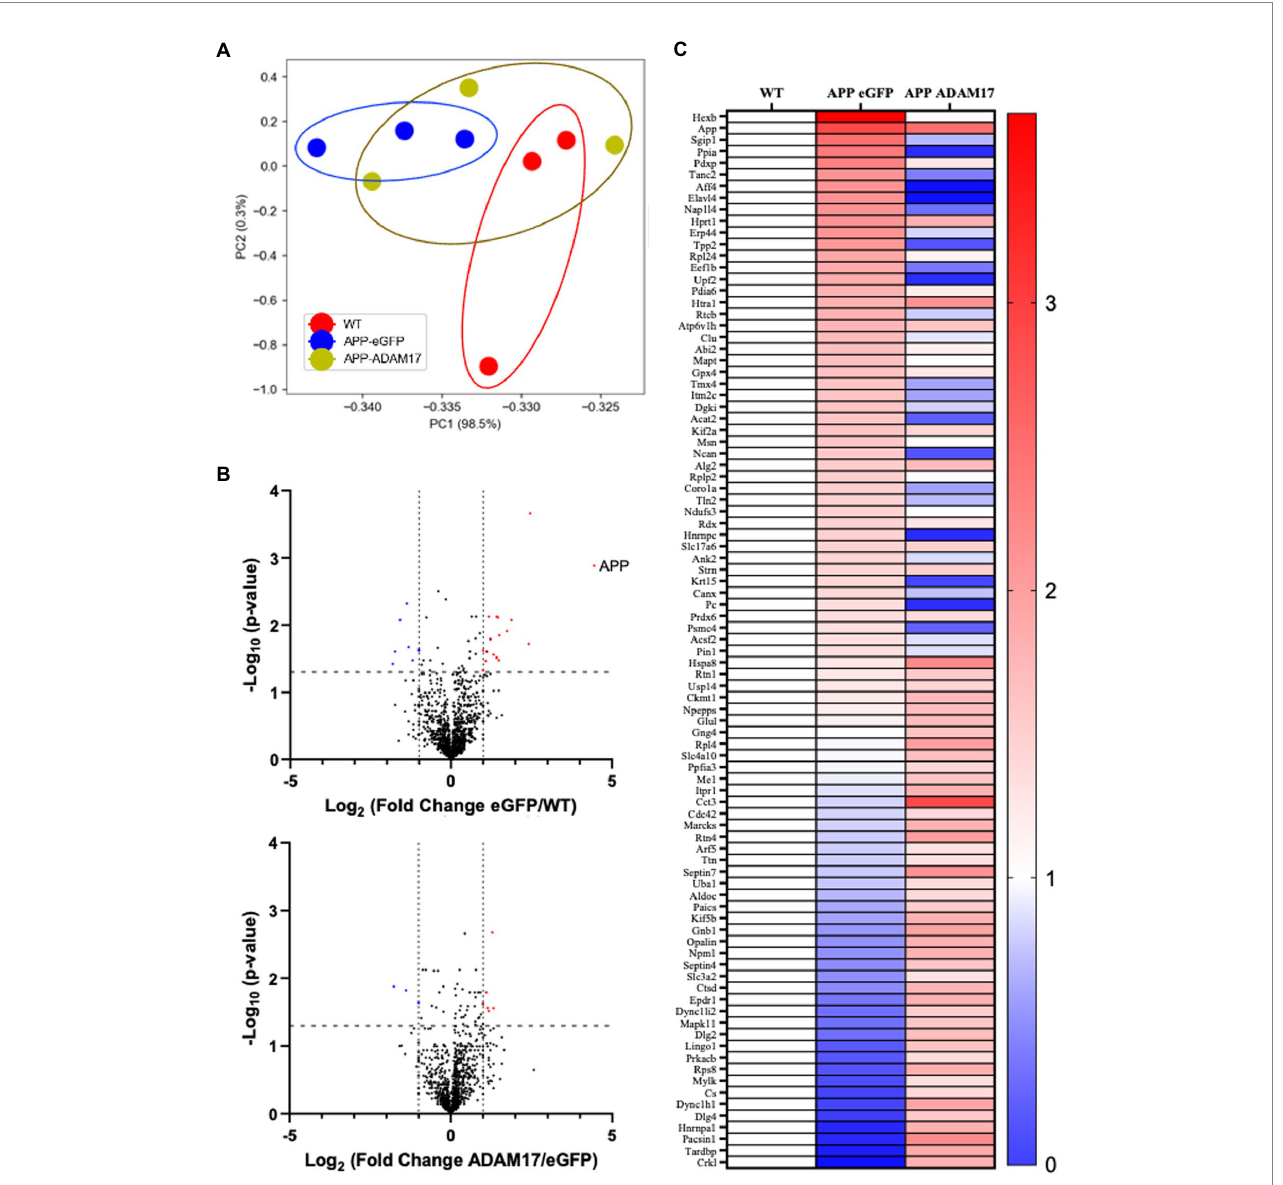
FIGURE 8 Proteomic profile of the brain of APP/PS1 mice. (A) A principal component analysis of proteins with Σ PSM per animal group ≥ 2, showing a difference in overall protein profiles between WT and eGFP mice, which was slightly corrected in the ADAM17 APP/PS1 mice. (B) Volcano plots of the protein profiles between WT/eGFP and eGFP/ADAM17 show the differentially up-and downregulated individual proteins. (C) Heatmap of the –log 10 (p-value) per group compared to WT show the up-and downregulated, significant proteins. 3 mice per group. * p < 0.05. Unpaired t -test was